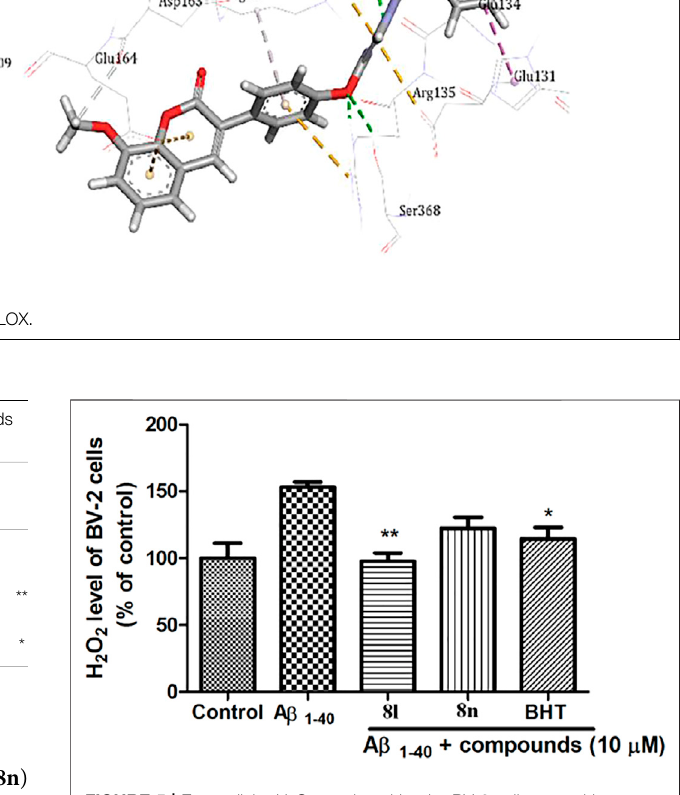
FIGURE 5 | Extracellular H 2 O 2 produced by the BV-2 cells treated by compounds 8l and 8n